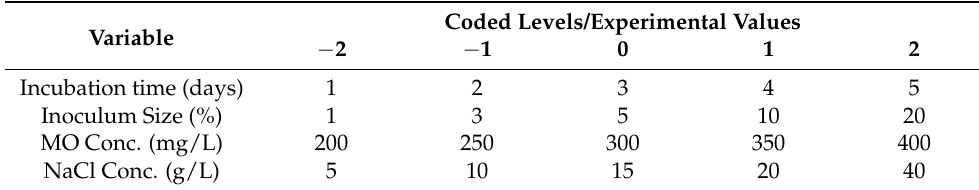
Table 1. The concentrations of examined variables (incubation time, inoculum size, MO conc. and NaCl) at each level in the CCD